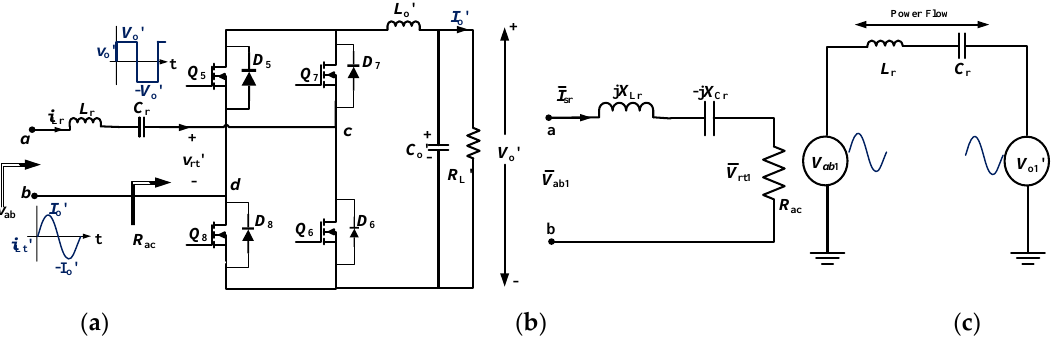
Figure 6. ( a ) Equivalent circuit of the converter with secondary referred to the primary side, ( b ). Phasor equivalent circuit at the output terminals of the inverter, ( c ). Equivalent circuit with the fundamental components of voltages.